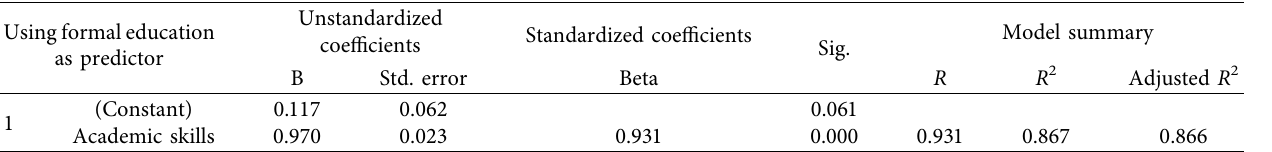
Table 9: Comparative regression.